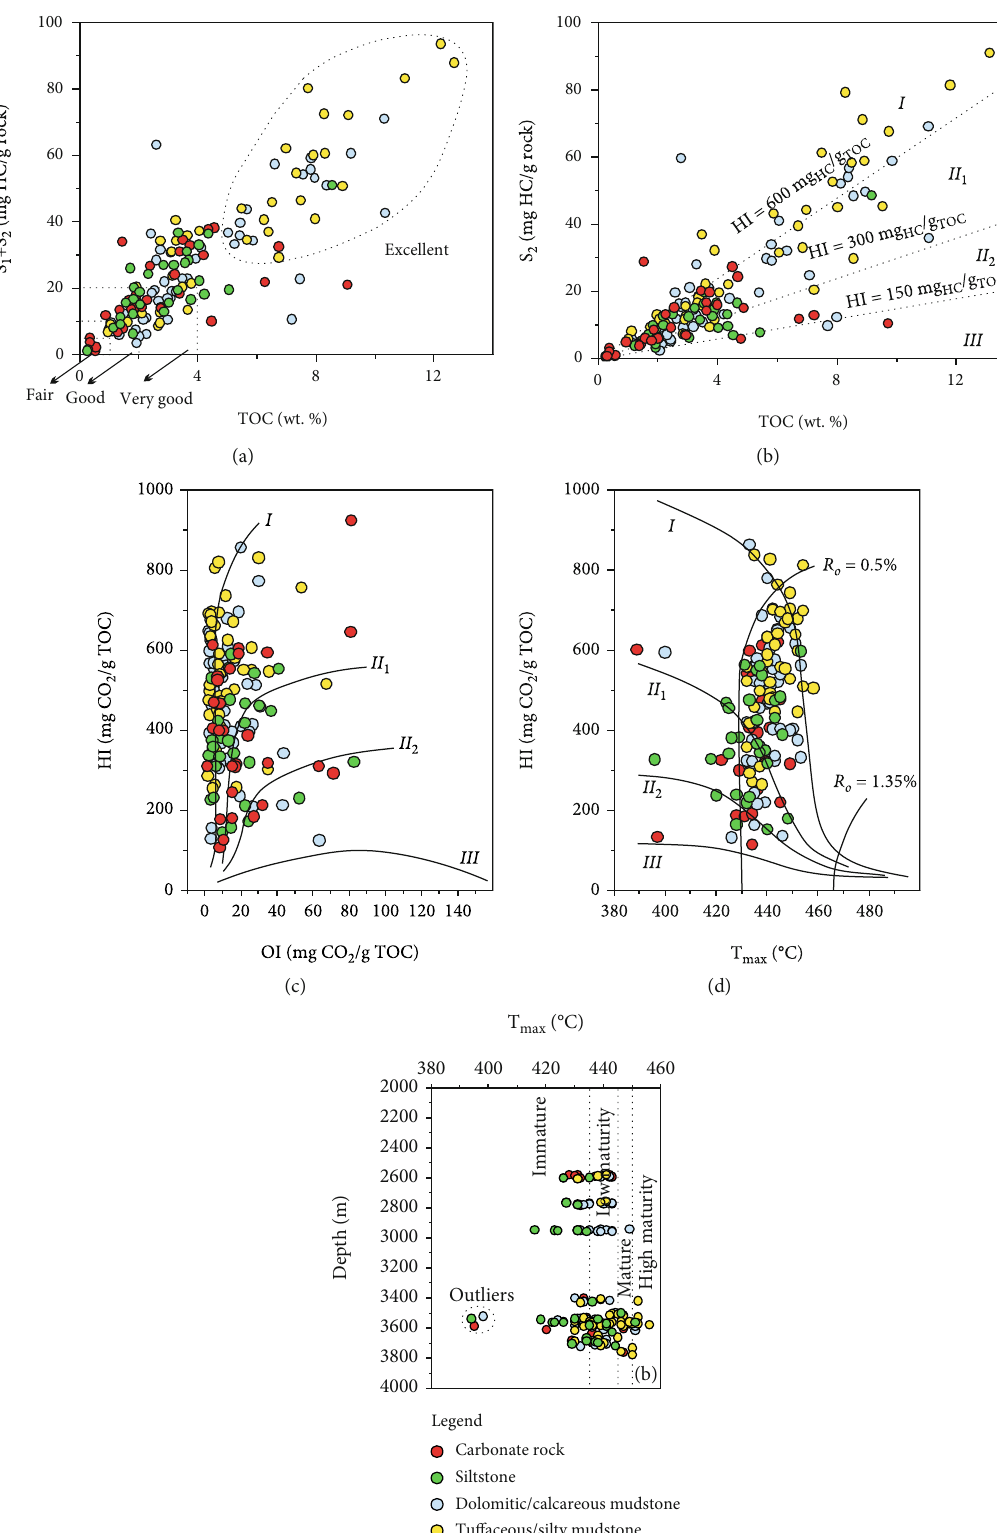
Figure 5: Organic matter contents, types, and maturity in the Lucaogou Formation, Jimusar Sag. (a) Organic matter contents of the di ff erent values versus TOC contents. (c) HI values versus OI plot. (d) HI values versus T lithologies. (b) Rock-Eval pyrolysis S 2 versus depth plot. The evaluation criteria are from